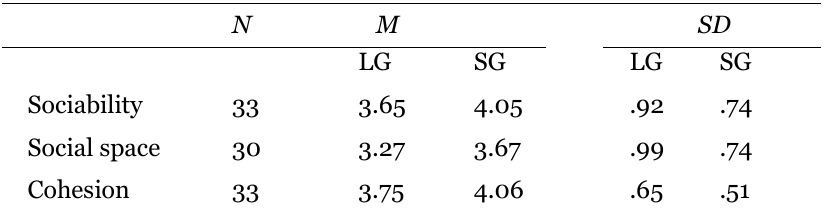
Descriptive Statistics for Group Cohesion, Sociability, and Social Space